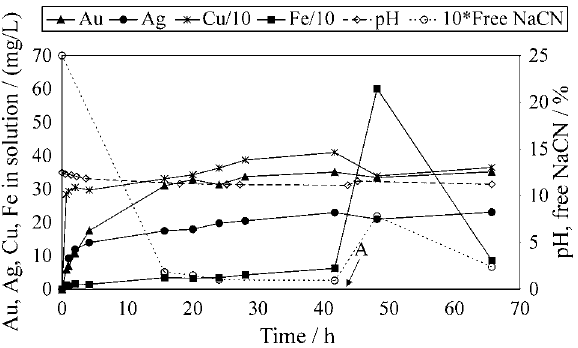
Figure 2. Cyanidation using 0.5% NaCN solution and the product milled to <0.3 mm; 1 kg of product, 1 L of solution, 50 g of lime; 0.13 and 3.93 g NaCN were added to the pulp at times A and B, respectively.